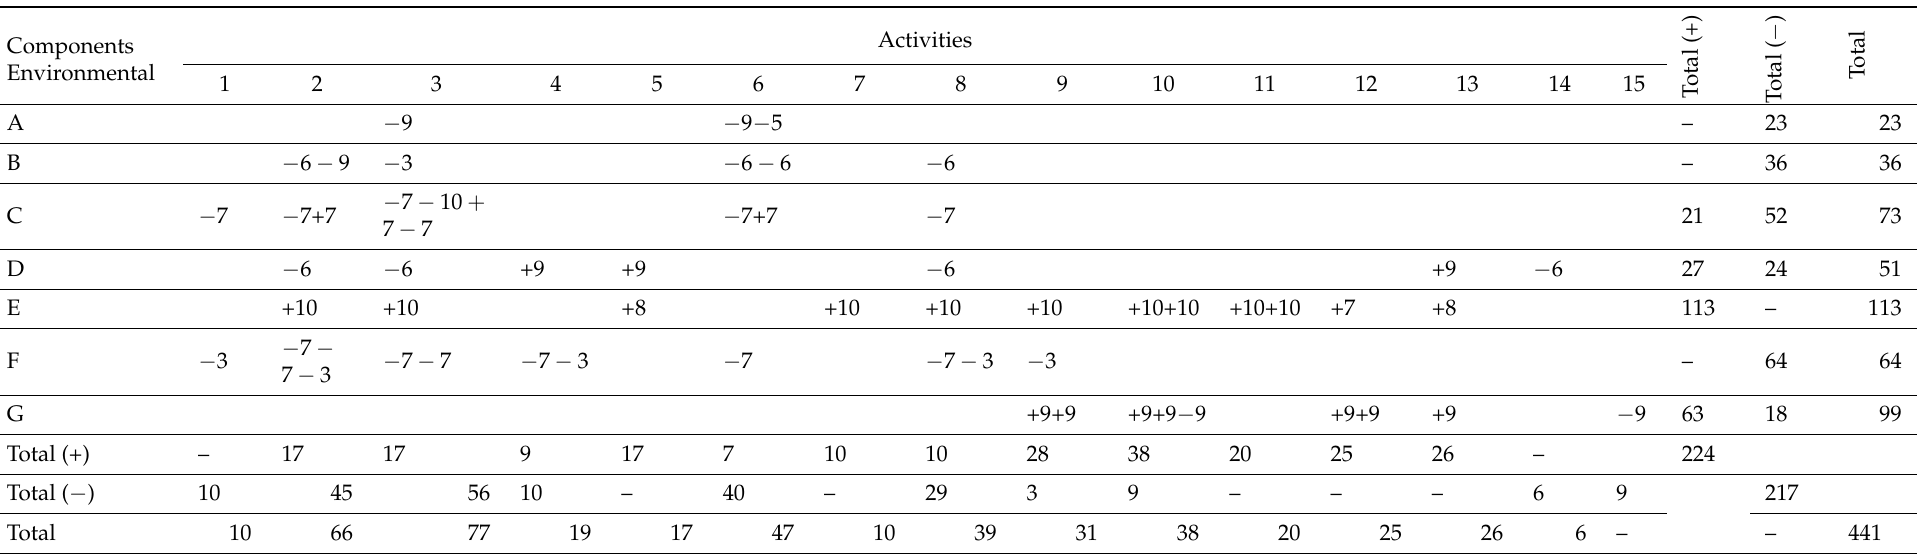
Table 3. Quantification